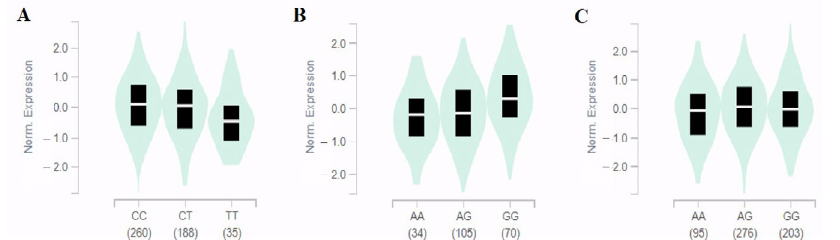
Figure 2. Identification of NKIRAS1 and SH2D4A expression and rs6550842 ( A ) and rs35651150 ( B , C ) in eQTL, respectively. Violin plots show NKIRAS1 expression in cultured fibroblasts for the Figure 2. Identi fi cation of NKIRAS1 and SH2D4A expression and rs6550842 ( a ) and rs35651150 ( b , c ) rs6550842 genotype (( A ), effect size = − 0.12, p = 7.3 × 10 − 5 ). The SH2D4A expression for the in eQTL, respectively. Violin plots show NKIRAS1 expression in cultured fi broblasts for the rs6550842 genotype (( a ), e ff ect size = − 0.12, p = 7.3 × 10 − 5 ). The SH2D4A expression for the rs35651150 rs35651150 genotype in the cerebellum (( B ), effect size = 0.37, p = 1.3 × 10 − 5 ) and thyroid (( C ), effect genotype in the cerebellum (( b ), e ff ect size = 0.37, p = 1.3 × 10 − 5 ) and thyroid (( c ), e ff ect size = 0.19, p size = 0.19, p = 7.7 × 10 − 9 ) was confirmed and statistically significant. Mean expression levels are = 7.7 × 10 − 9 ) was con fi rmed and statistically signi fi cant. Mean expression levels are indicated by the indicated by the white line and 25% and 75% quantiles are shown by the black box. Data white line and 25% and 75% quantiles are shown by the black box. Data were obtained via GTEx browser (h tt ps://gtexportal.org/ (accessed on 10 March 2023)).